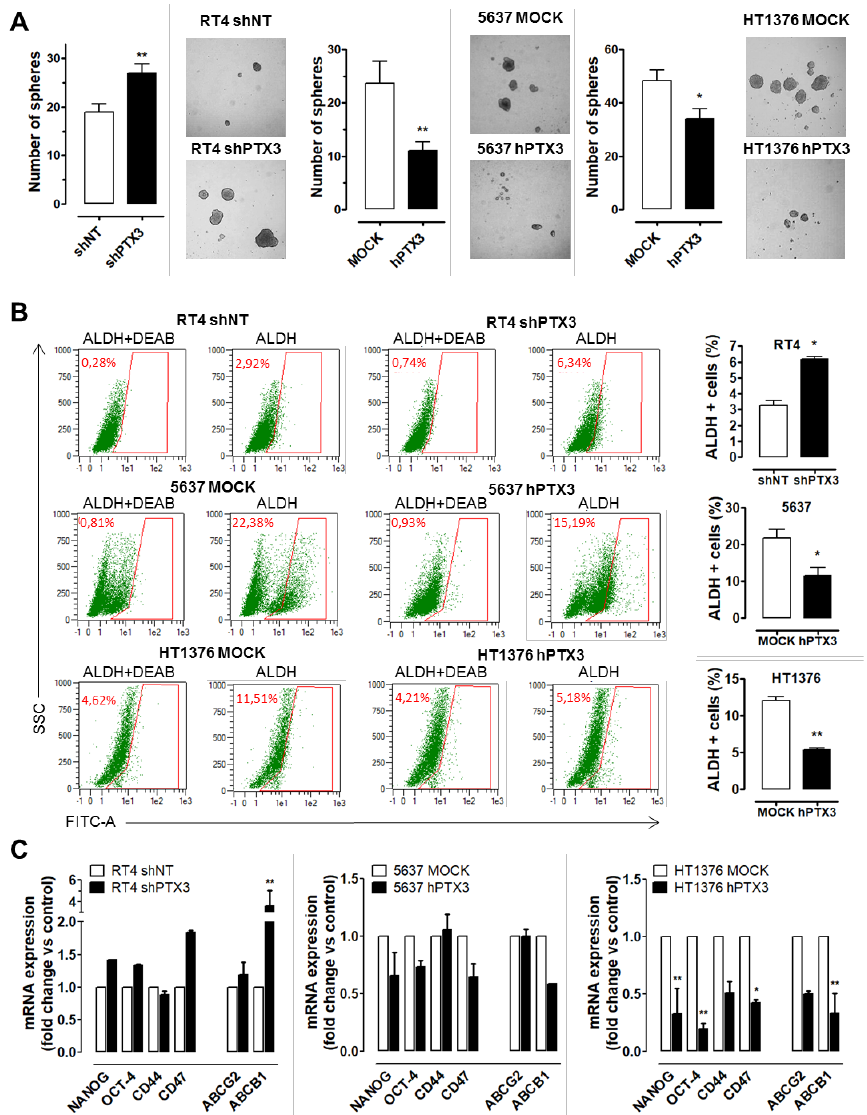
Figure 5. PTX3 modulation affects stem-like features in BC cells. ( A ) Sphere formation assay performed on RT4, 5637, and HT1376 transfectants. Quantification of sphere number (histograms) and representative images are shown. ( B ) Flow cytometry analysis of ALDH activity in modulated BC sphere-forming cells. The ALDH inhibitor DEAB was used as negative control for baseline fluorescence of cells. Histograms show the percentage of ALDH + cells (mean ± SEM, n = 3). ( C ) Quantitative RT-PCR analysis of stemness and drug resistance genes in PTX3-modulated BC cells. * p < 0.05, ** p < 0.01.